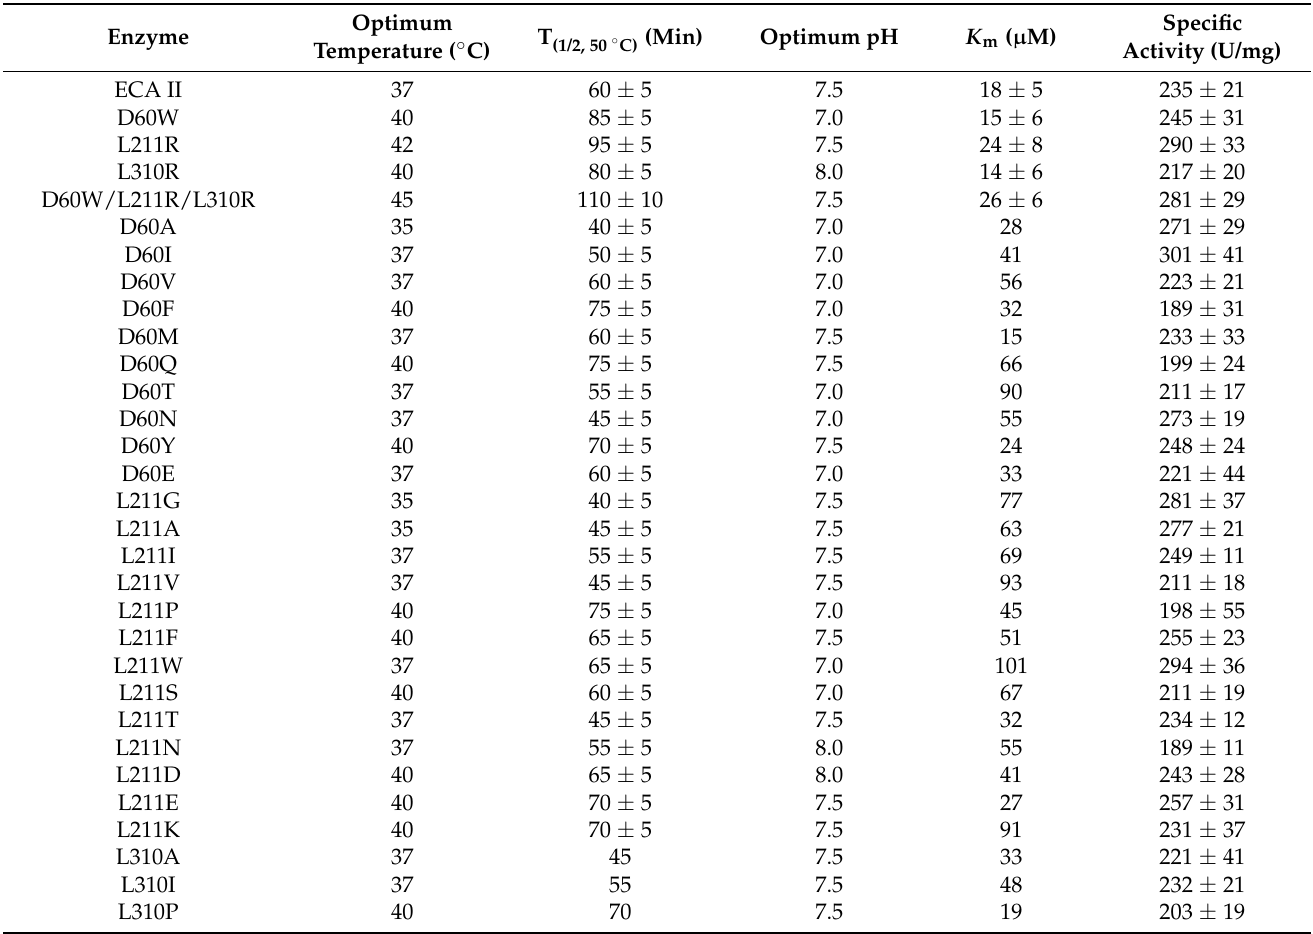
Table 1. The enzyme characteristics of ECAII and its